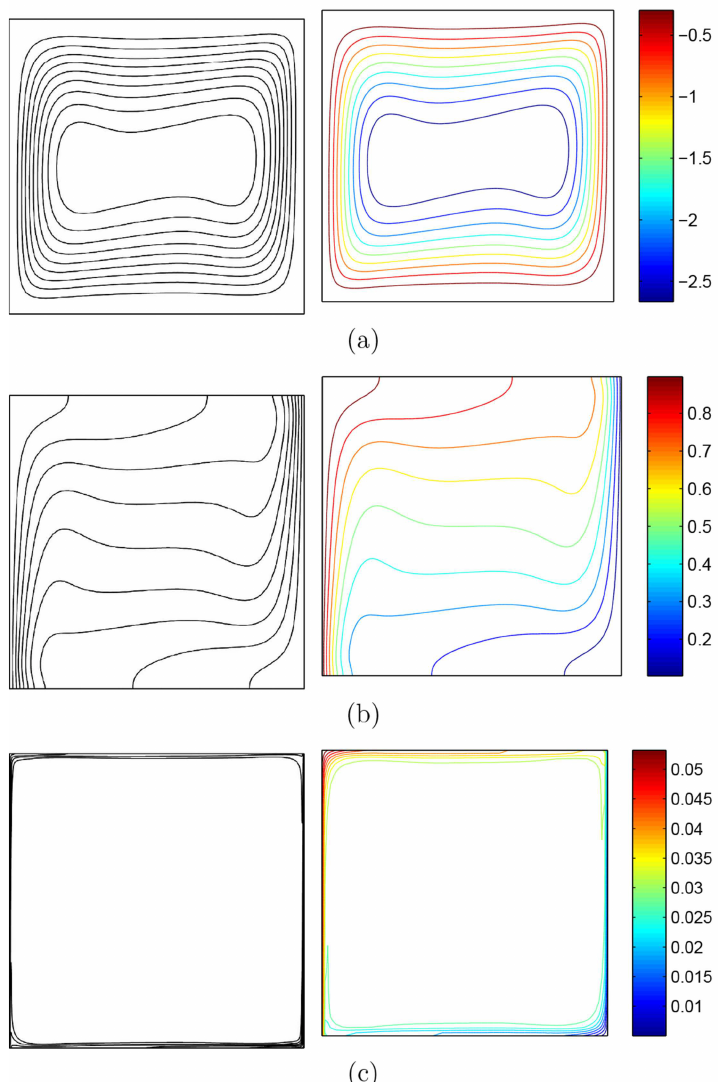
Figure 4. (left) Corcione et al. [39] vs. (right) present study: ( a ) streamlines; ( b ) isotherms; and ( c ) nanoparticle distribution for the case where Ra = 3.37 × 10 5 , φ = 0.04, and D =